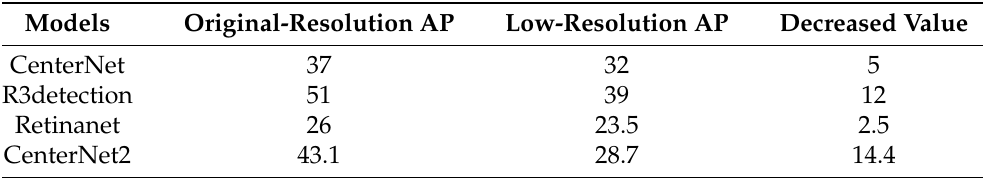
Table 1. Performance comparison of state-of-the-art object detectors on original and low-resolution remote sensing images. The detection performance decreases dramatically for small sized objects in low-resolution